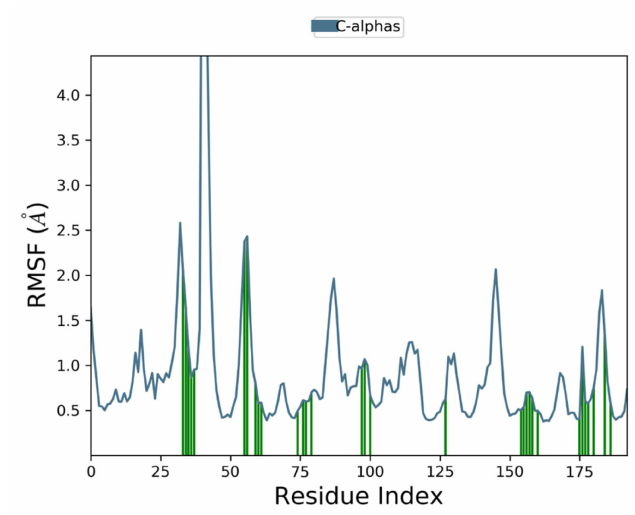
Figure 8. Root Mean Square Fluctuation plot of Comp1 and NS2B-NS3 complex of ZIKV.